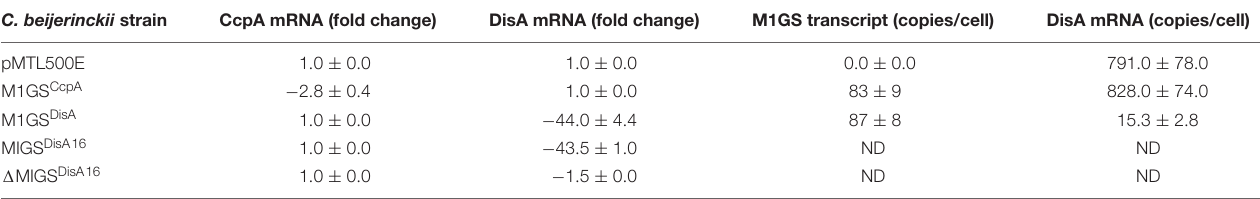
TABLE 2 | Determination of fold-change for CcpA and DisA mRNA level and of the cellular copy number for M1GS and DisA transcripts. C. beijerinckii strain CcpA mRNA (fold change) DisA mRNA (fold change)